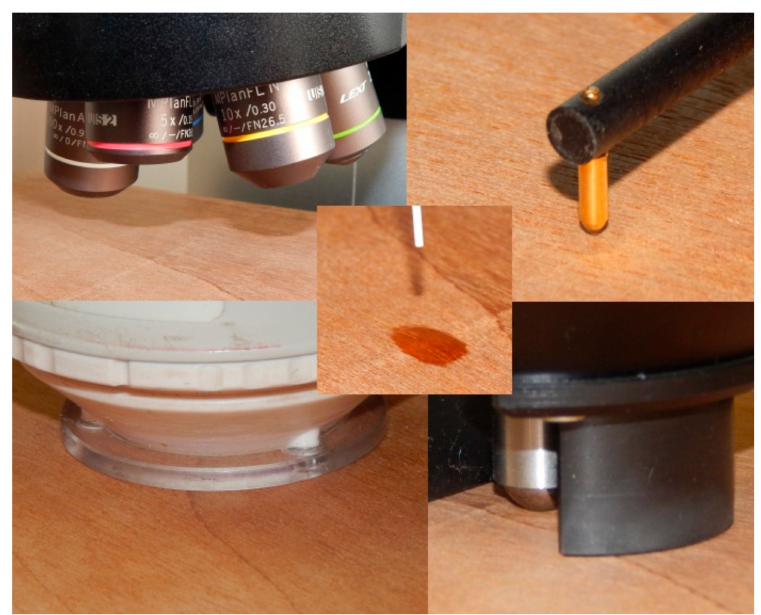
Figure 4. The photographic details of the principle of experimental